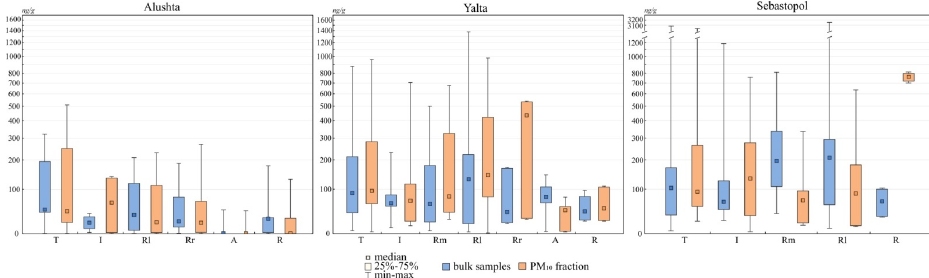
Figure 2. The content of BaP in soils and their PM 10 fraction in the land use zones of Alushta, Yalta and Sebastopol. Zones: T—traffic, I—industrial, Rm and Rl—residential with multi ‐ storey and low ‐ rise buildings, A—agrogenic, Rr—residential and recreational, R—recreational.